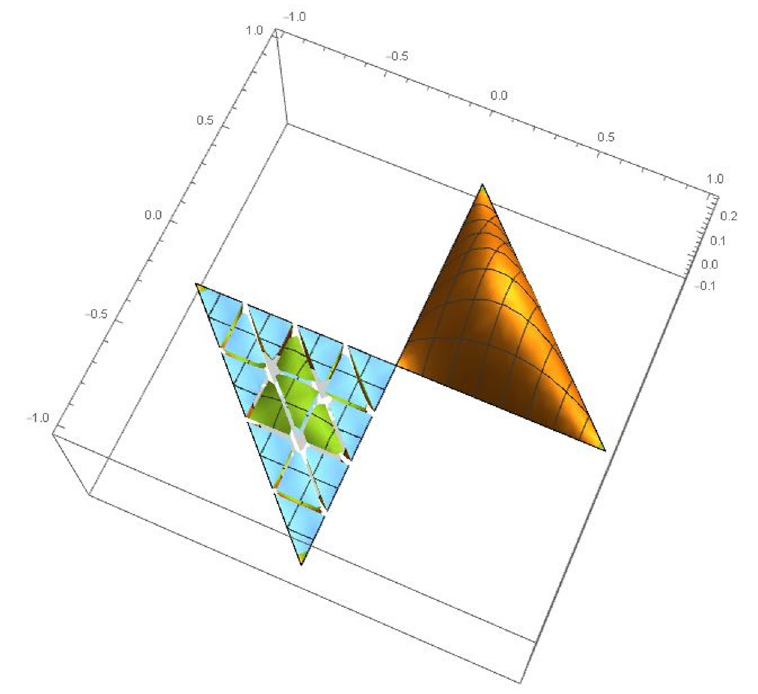
Figure 3. The functions C (cid:0) 3 P 3 (cid:20) ( C (cid:1) a ) for C = 1 (brown), C = 2 (green), and C = 4 (blue). a =1 The take-over of the green curve signi(cid:12)es the partially decon(cid:12)ned phase in that region when N = 4.